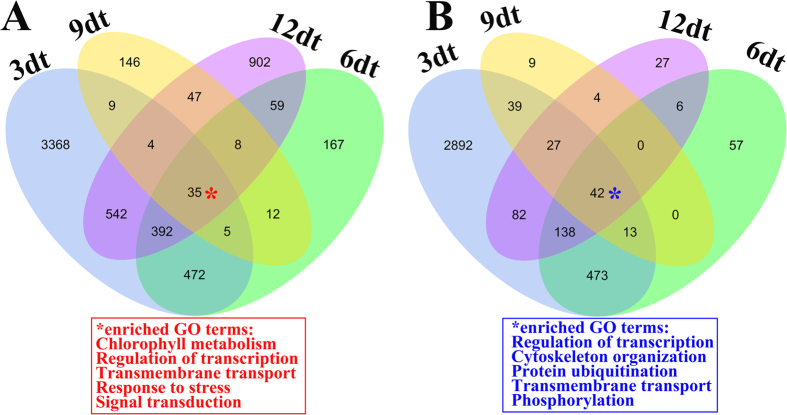
Overview of the transcriptional changes occurring in abscised SDM shoot induced by ethephon.Venn diagram representing unigenes upregulated (A) and downregulated (B) induced by ETH in abscised SDM shoots at 3, 6, 9, and 12 days. Red and blue asterisk (*) represented enriched GO terms of up- or down-regulated unigenes, respectively.